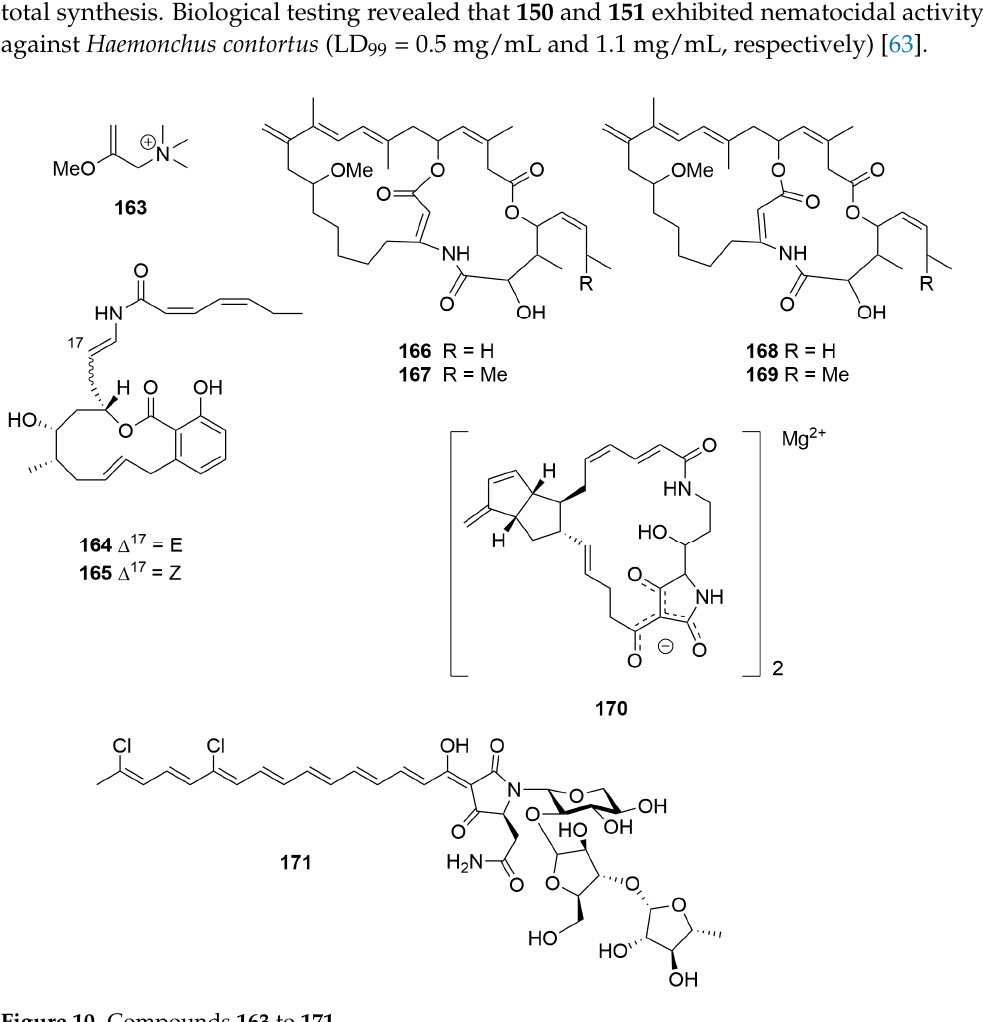
Figure 10. Compounds 163 to 171